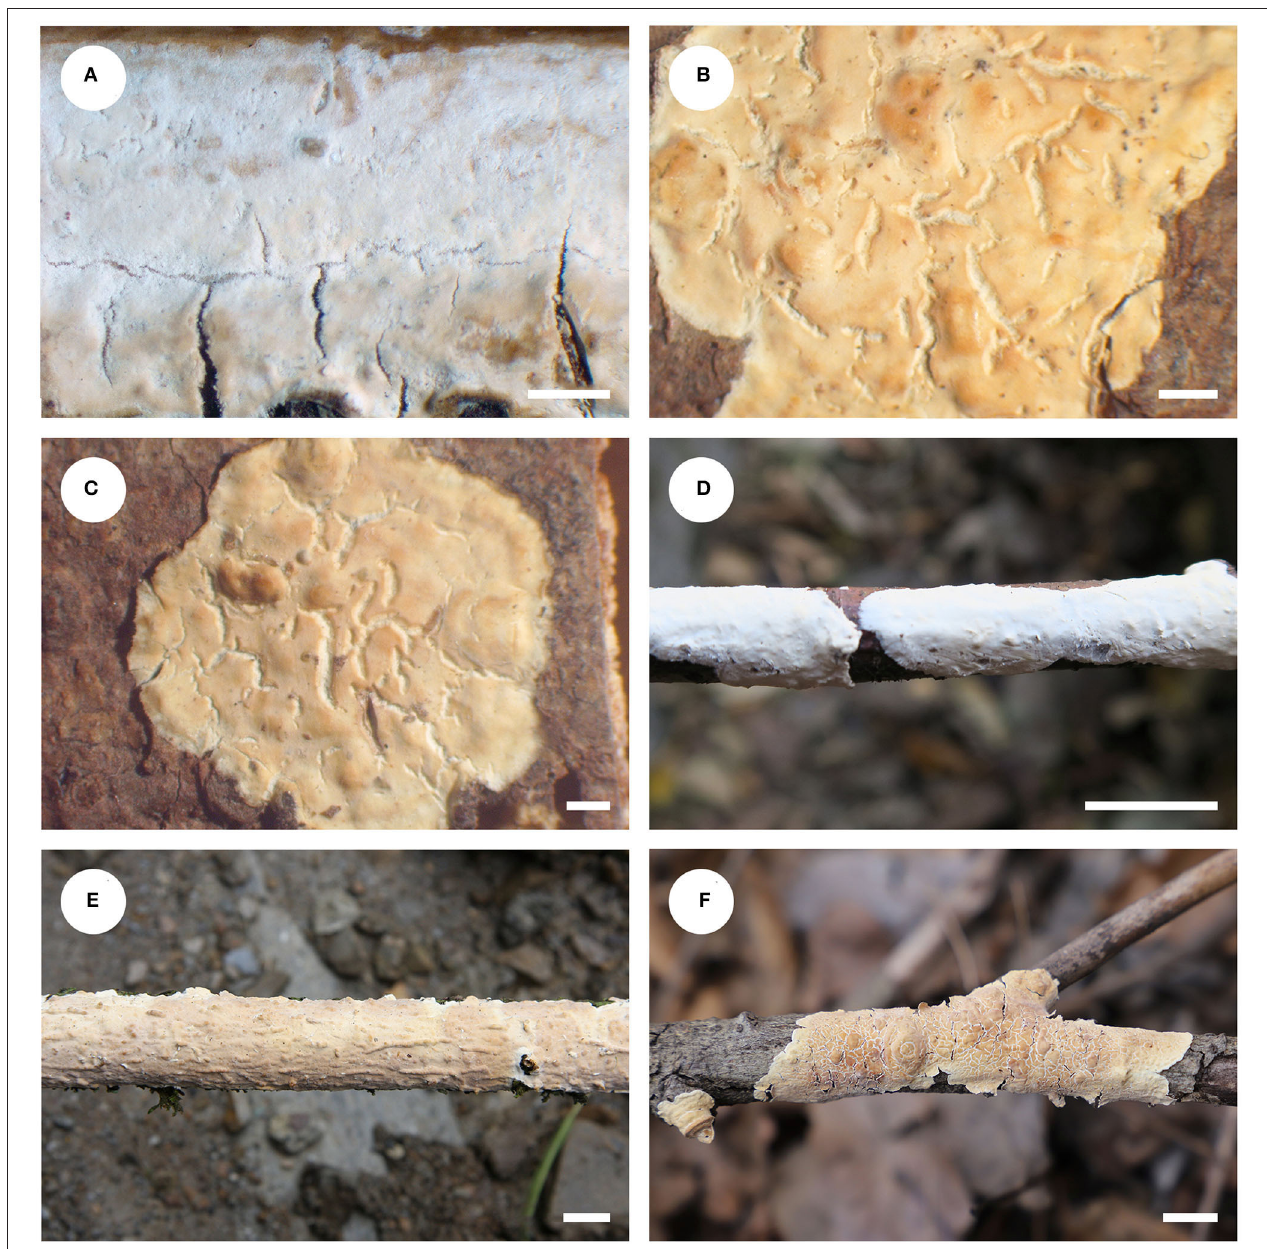
FIGURE 12 | Basidiomata of Phanerochaetella queletii (scale bars: A–F = 1cm). (A) K(M) 146494 (holotype of Corticium jose-ferrieriae ); (B) BPI 282568 (holotype of C. queletii ); (C) F11364 (isotype of C. queletii ); (D) He 3284; (E) He 20120917-10; (F) He 7467.